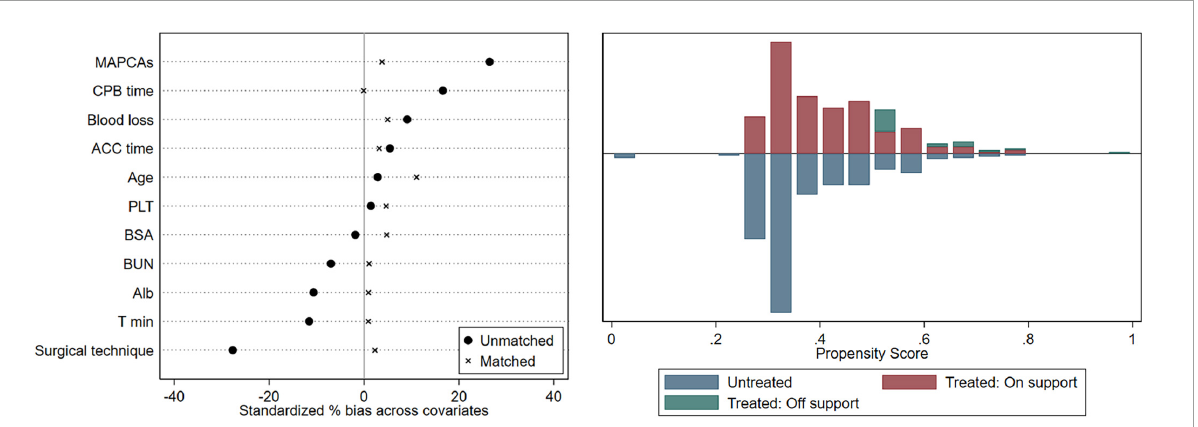
FIGURE3 Equilibrium test. CPB, cardiopulmonary bypass; ACC, aortic cross-clamp; PLT, platelet; BSA, body surface area; BUN, blood urea nitrogen; ALB, albumin; T min , the minimum